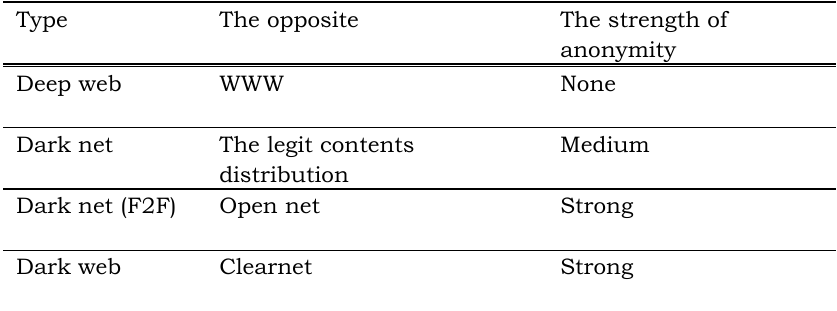
Table 1. Deep web, dark web, and (two) dark nets Type The opposite The strength of anonymity Deep web WWW None Dark net The legit contents distribution